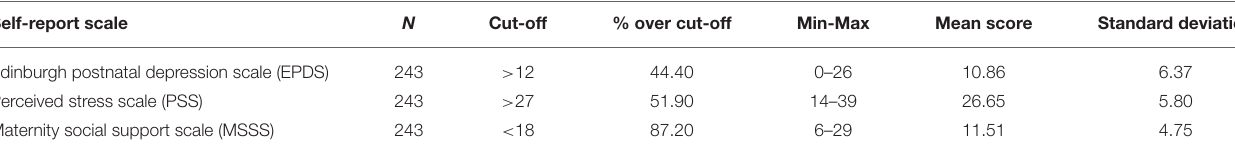
TABLE 2 | Self-report scales cut-off for clinical significance and % of the sample above cut-off. Self-report scale